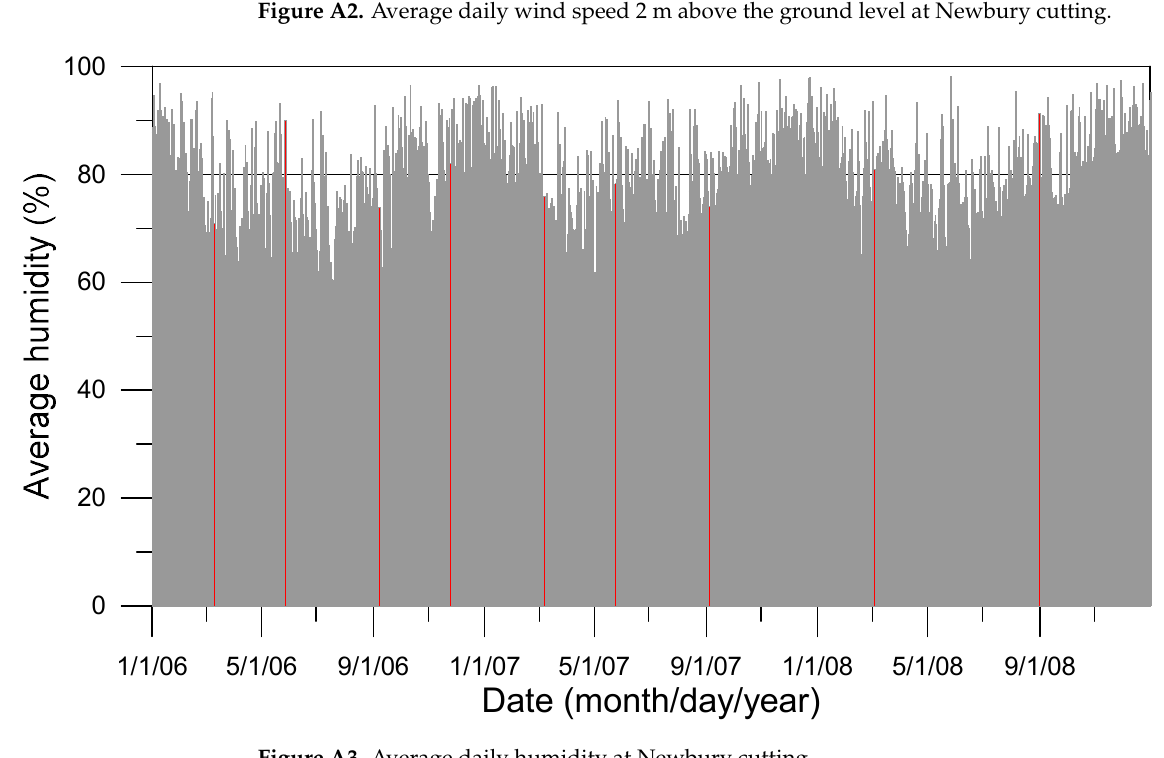
Figure A3. Average daily humidity at Newbury cutting.